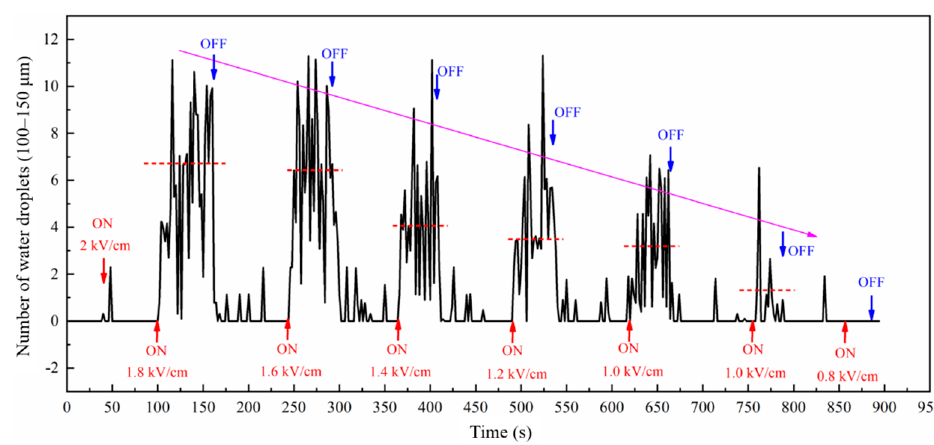
Figure 9. Variations of water droplet number within 50 to 100 μ m.